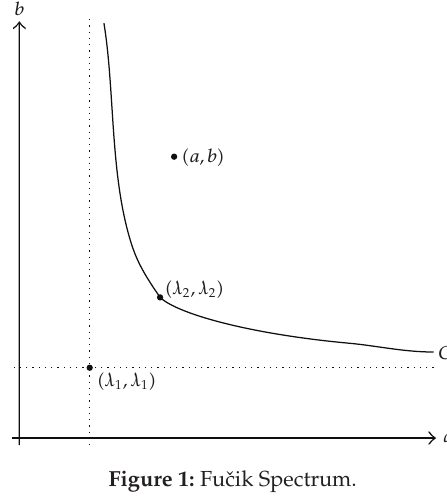
Figure 1: Fuˇcik